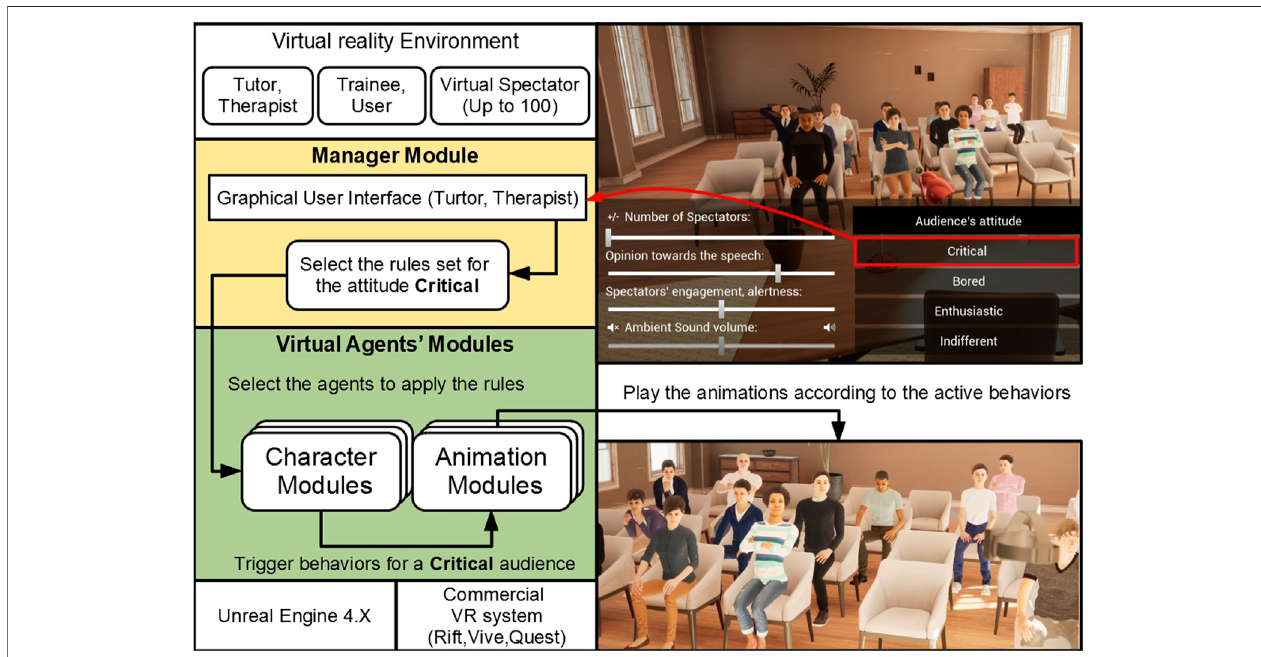
FIGURE 2 | Global architecture of the system with the example of rules applied to display a Critical attitude.